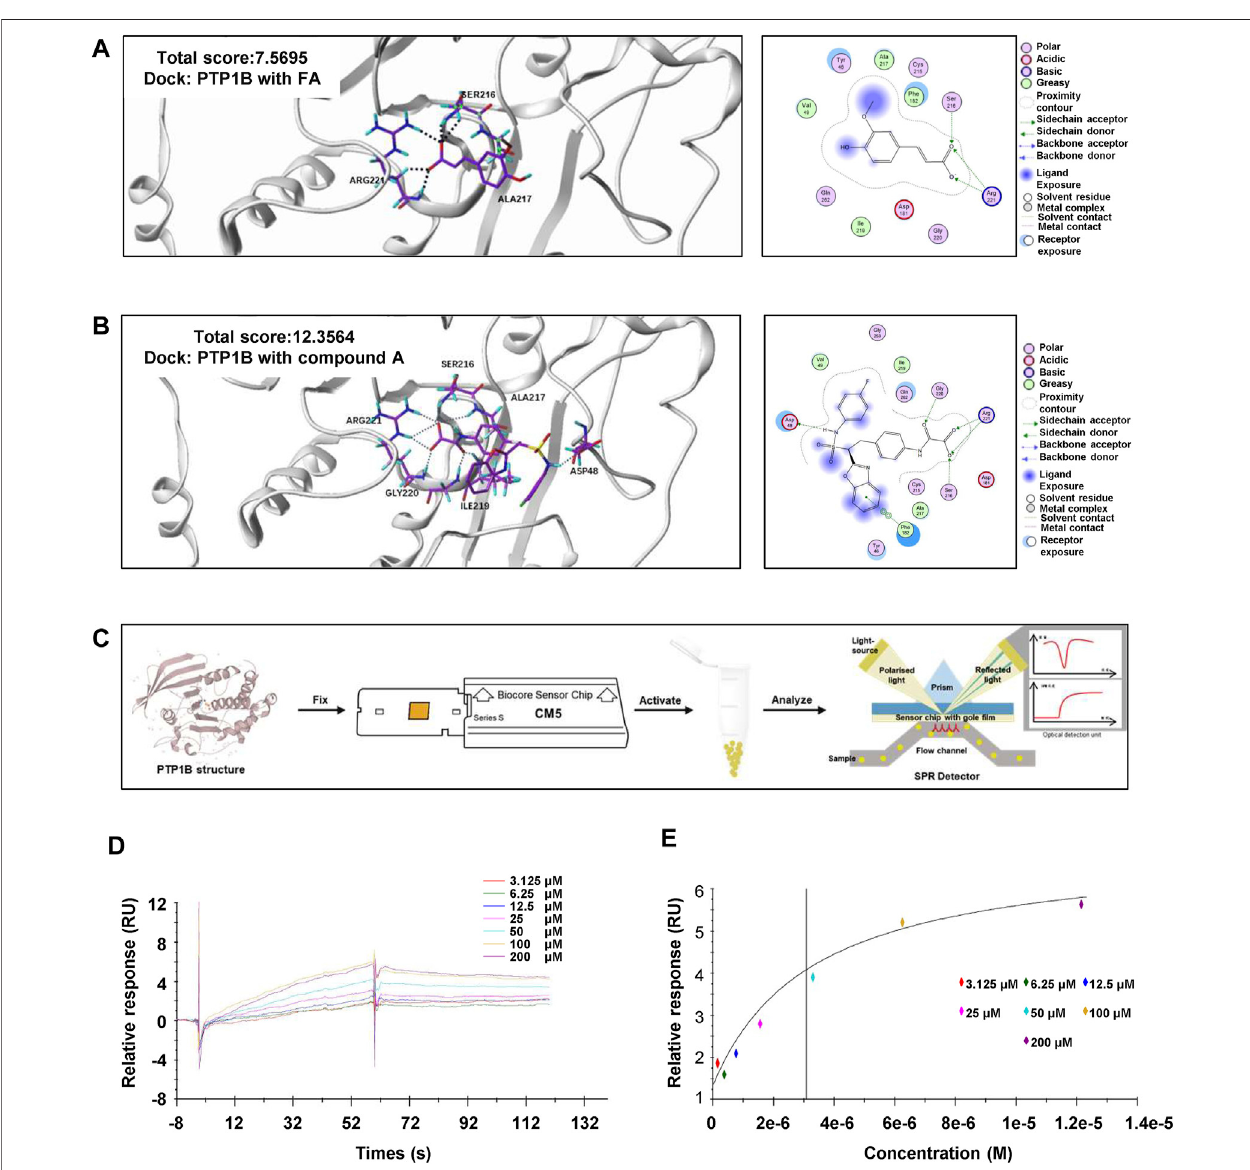
FIGURE 5 | FA directly binds to PTP1B. (A) Representative images for the binding mode of FA and PTP1B with the crystal structure of PTP1B (PDB ID: Ser216, Arg221, Ala217). (B) Representative images for the binding mode of compound A and PTP1B with the crystal structure of PTP1B (PDB ID: Arg221, Ser216, Ala217, Gly220, Ile219 and Asp48). (C) The process fl ow diagram of SPR. (D) The concentration gradient binding curves of protein PTP1B with FA (3.125, 6.25, 12.5, 25, 50, 100 and 200 μ M). (E) The representative binding curve of FA binding to PTP1B. All the experiments were conducted three independent times.